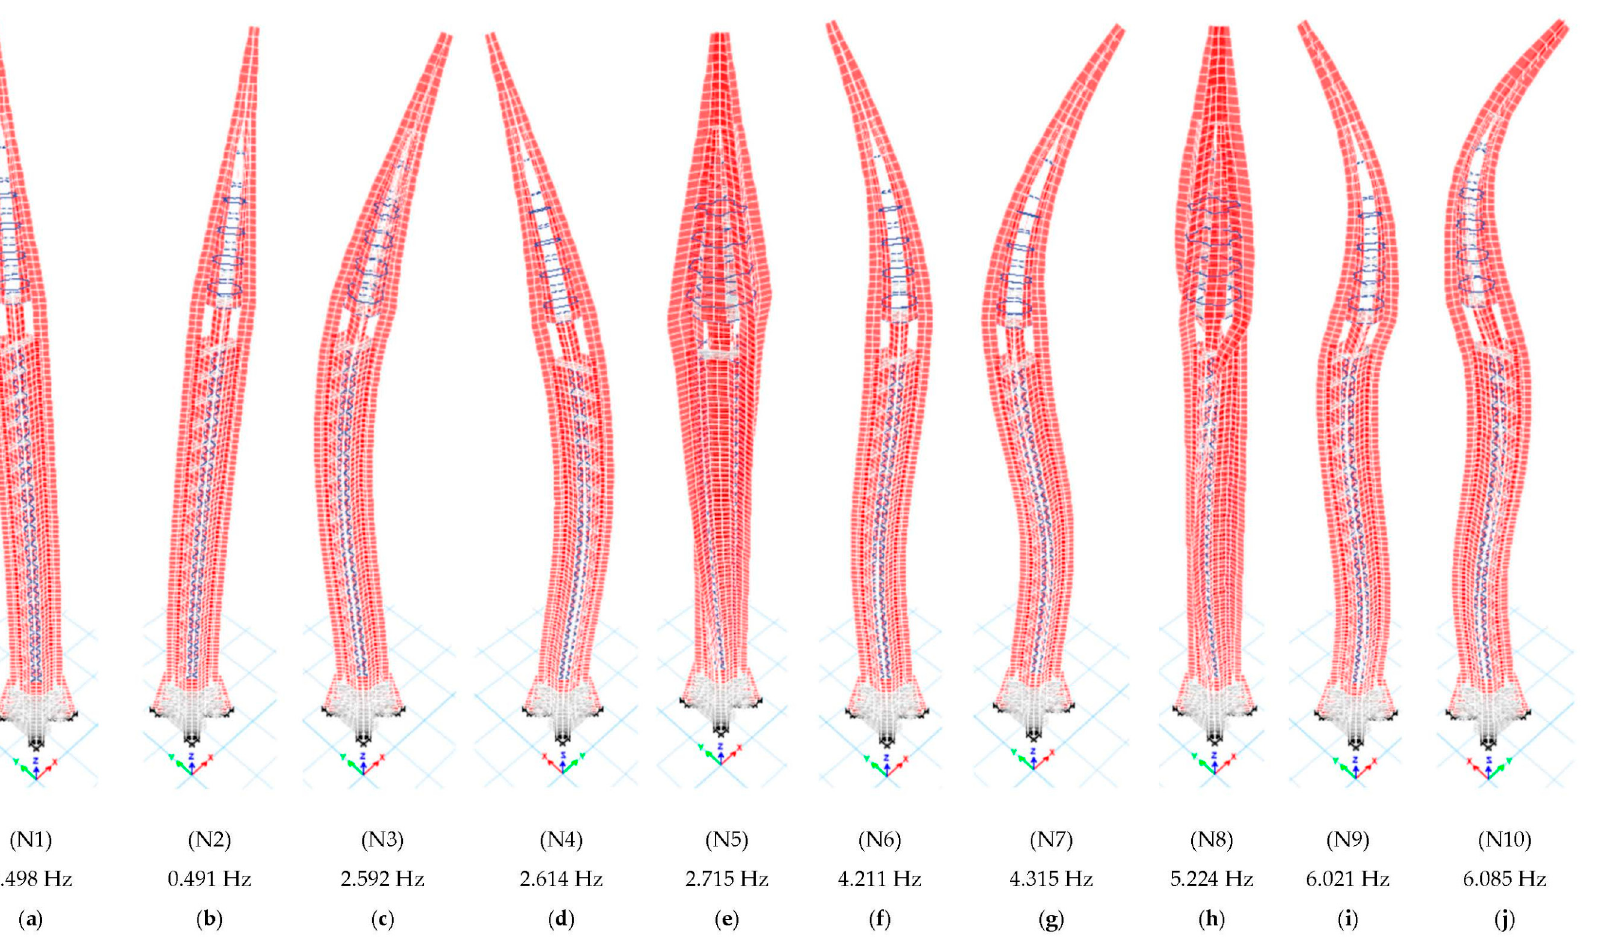
Figure 12. Numerical mode shapes, along with the natural frequencies. ( a ) First mode. ( b ) Second mode. ( c ) Third mode. ( d ) Fourth mode. ( e ) Fifth mode. ( f ) Sixth mode. ( g ) Seventh mode. ( h ) Eighth mode. ( i ) Ninth mode. ( j ) Tenth mode.